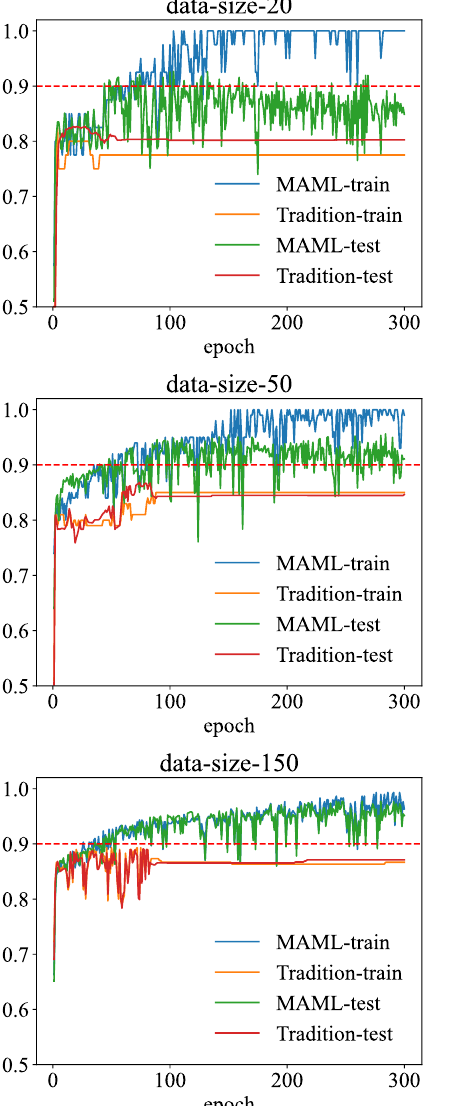
Figure 14. Training process of MAML-ANN and traditional ANN.